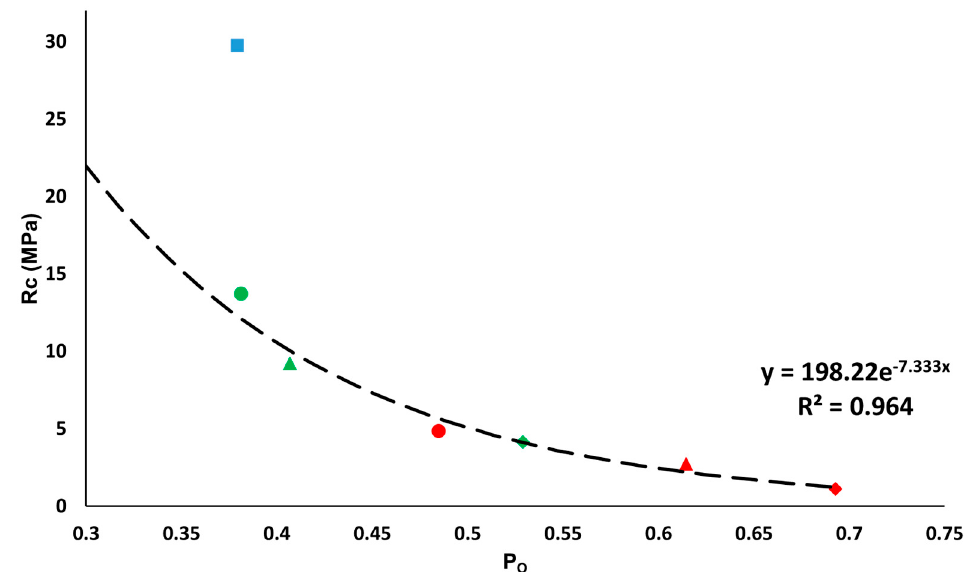
Figure 9. Relationship between the uniaxial compression resistance (Rc, in MPa) and the open porosity (P o , per unit) obtained by the hydric tests. This figure represents control samples (blue square), samples with EPS (green) and samples with olive stones (red) at 20% (circle), 40% (triangle) and 60% (diamond). The trendline is calculated for the samples with additives.